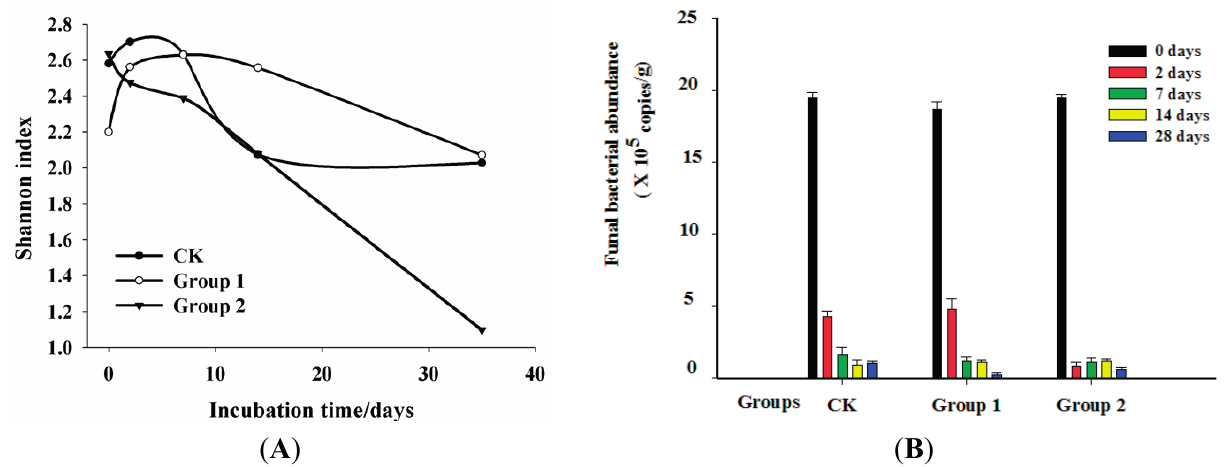
Figure 2. Shannon index for the fungal communities based on the DGGE profile ( A ) and the dynamics of fungal abundance 18S rDNA gene copy number during the incubation ( B